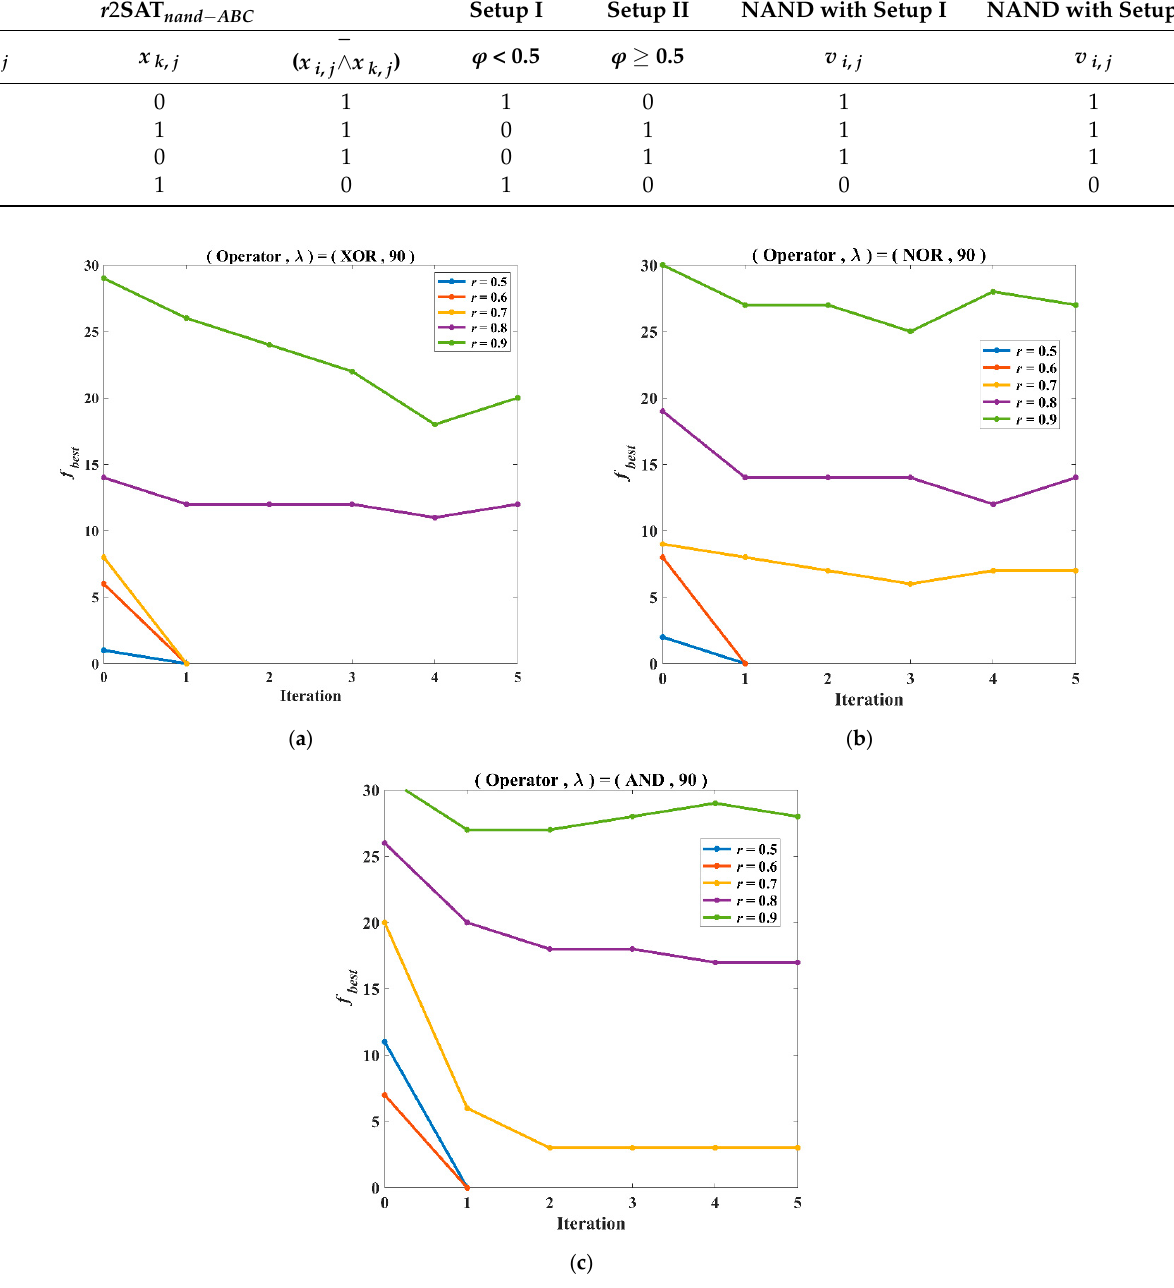
Table 15. Position update in Equation (14) with NAND logic gate operator with equal probability (unbiased φ ).